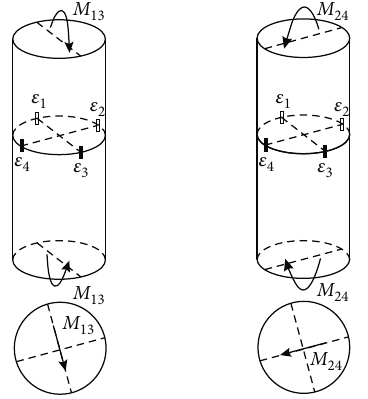
Figure 7: Schematic diagram of the bending moment.